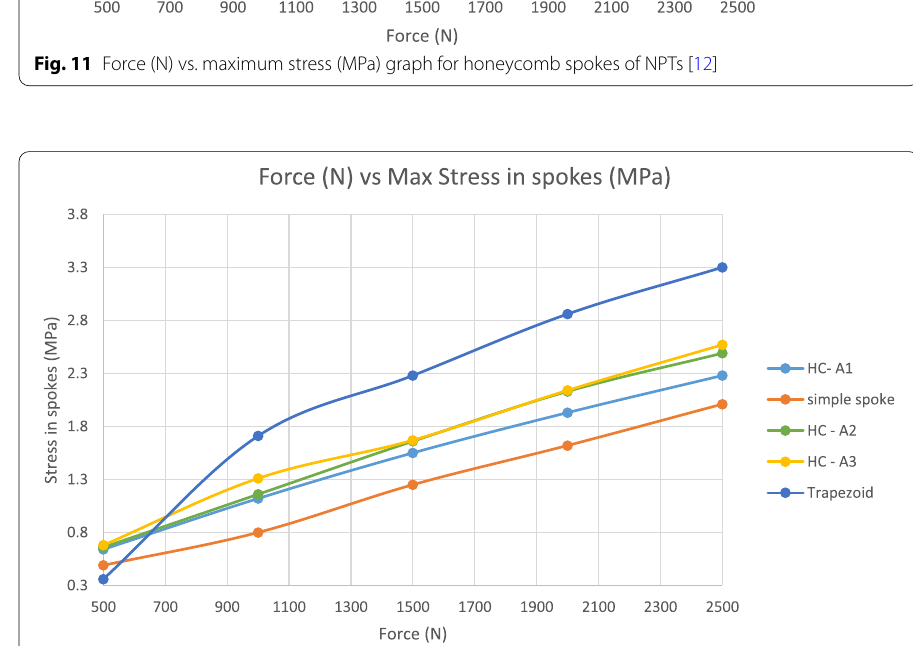
Fig. 11 Force (N) vs. maximum stress (MPa) graph for honeycomb spokes of NPTs [12]